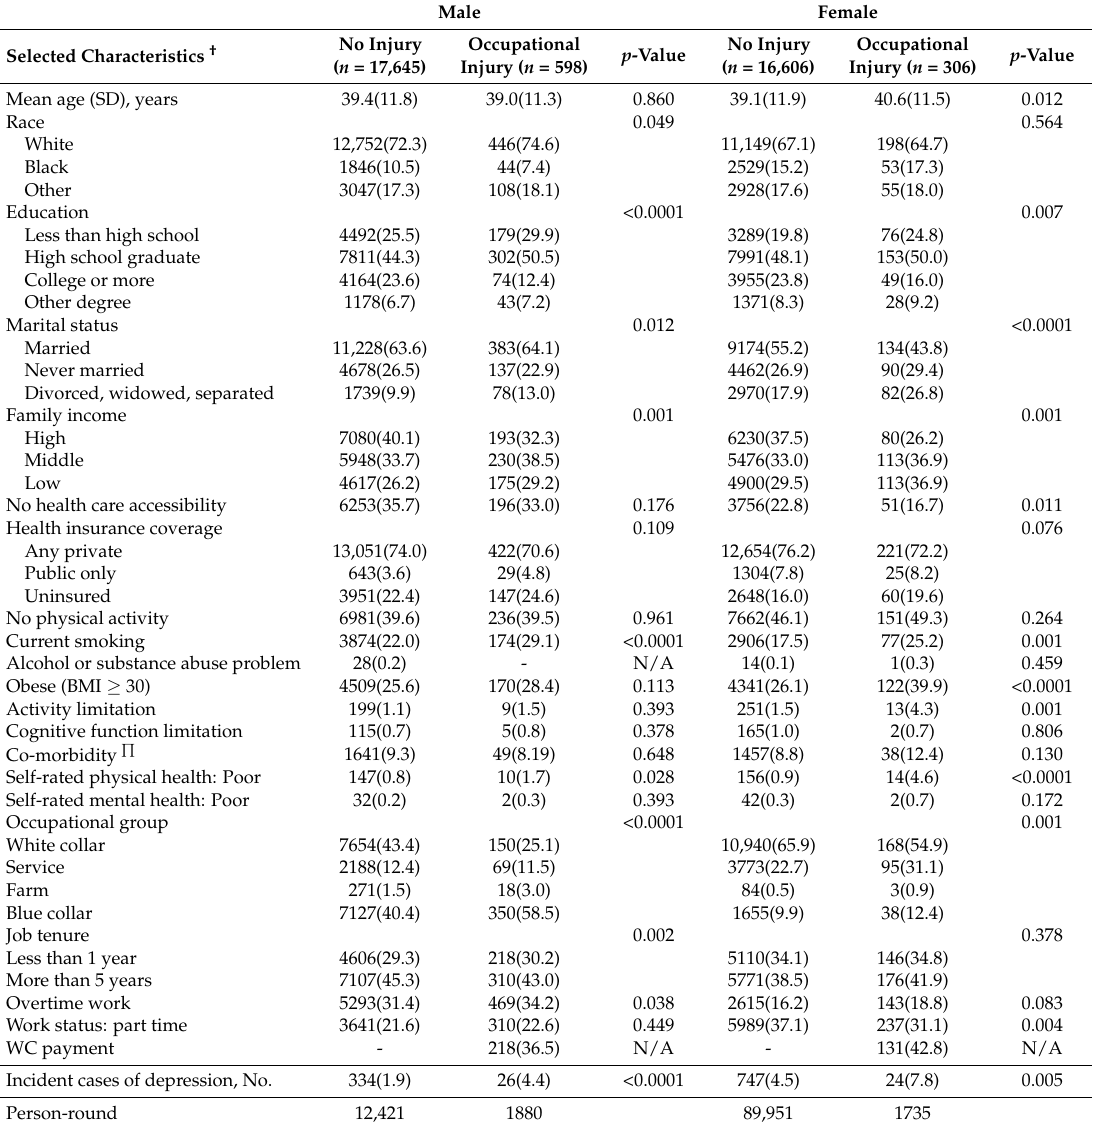
Table 1. Characteristics of men and women without prevalent depression by occupational injury status in the Medical Expenditure Panel Survey (MEPS),